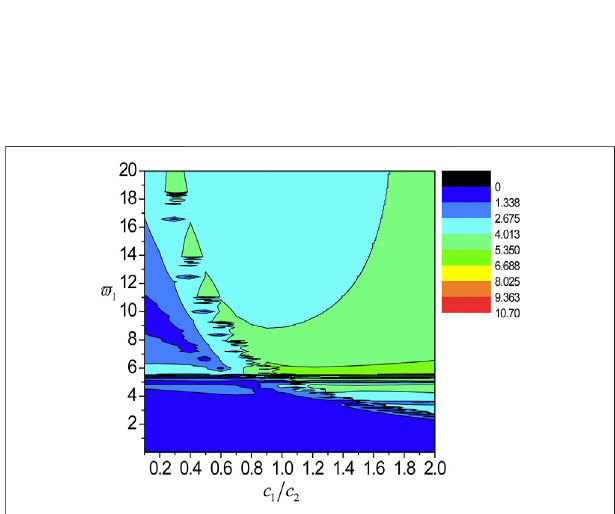
FIGURE 11 | The localization factors varying with the normalized frequency and c 1 /c 2 for the SH wave propagating normally in the nanoscale Cu/Al Fibonacci laminate for τ 1 = τ 2 =